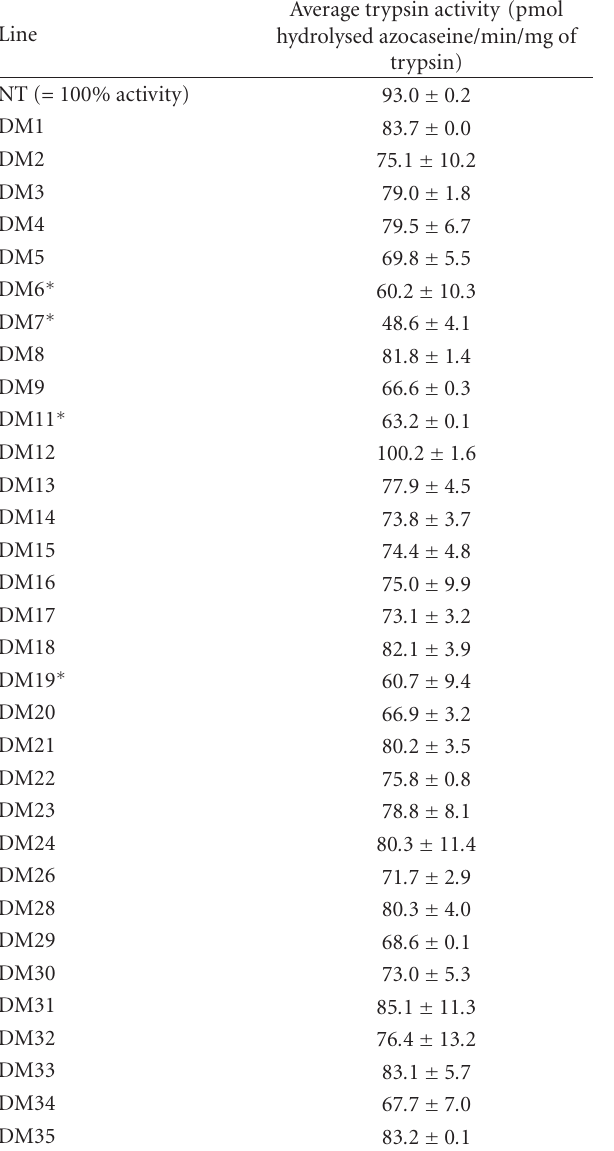
Table 1: Average ( ± s.d.) trypsin activity in presence of leaf protein crude extracts from nontransformed (NT) and mti-2 -expressing potato lines.